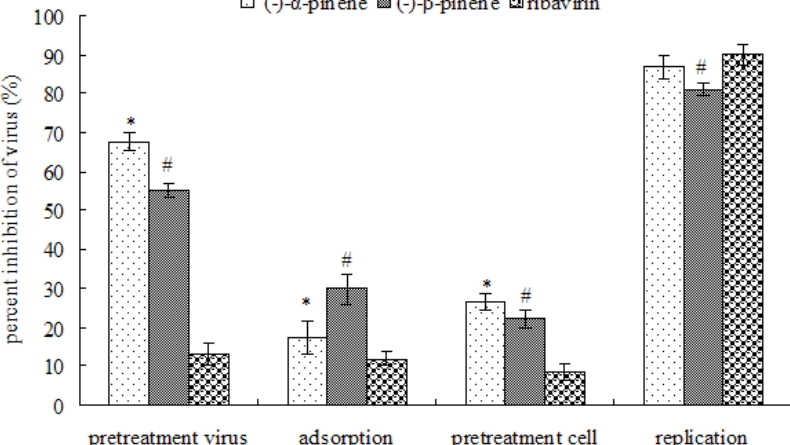
Cells were pretreated with (-)- α -pinene, (-)- β -pinene or ribavirin prior to virus infection (pretreatment cells), viruses were pretreated prior to infection (pretreatment virus), and (-)- α -pinene, (-)- β -pinene or ribavirin was added during the adsorption period (adsorption) or after penetration of the viruses into cells (replication). Experiments were repeated independently three times and data presented are the average of 3 experiments. The symbols * and # indicated very significant difference p < 0.01 with respect to positive control